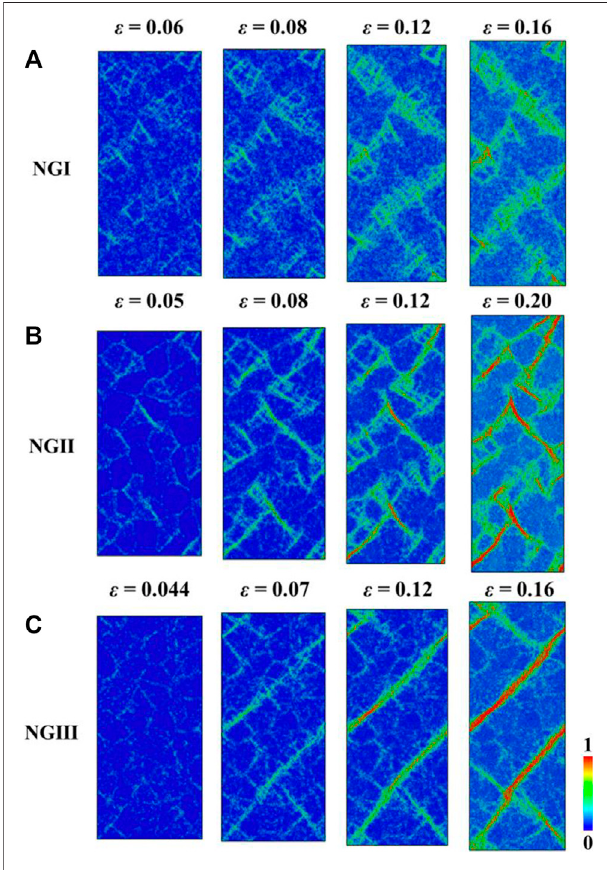
FIGURE 6 | (A – C) Sequence of snapshots capturing the atomic deformation processes for NGI, NGII, and NGIII, respectively. The colors indicate the atomic shear